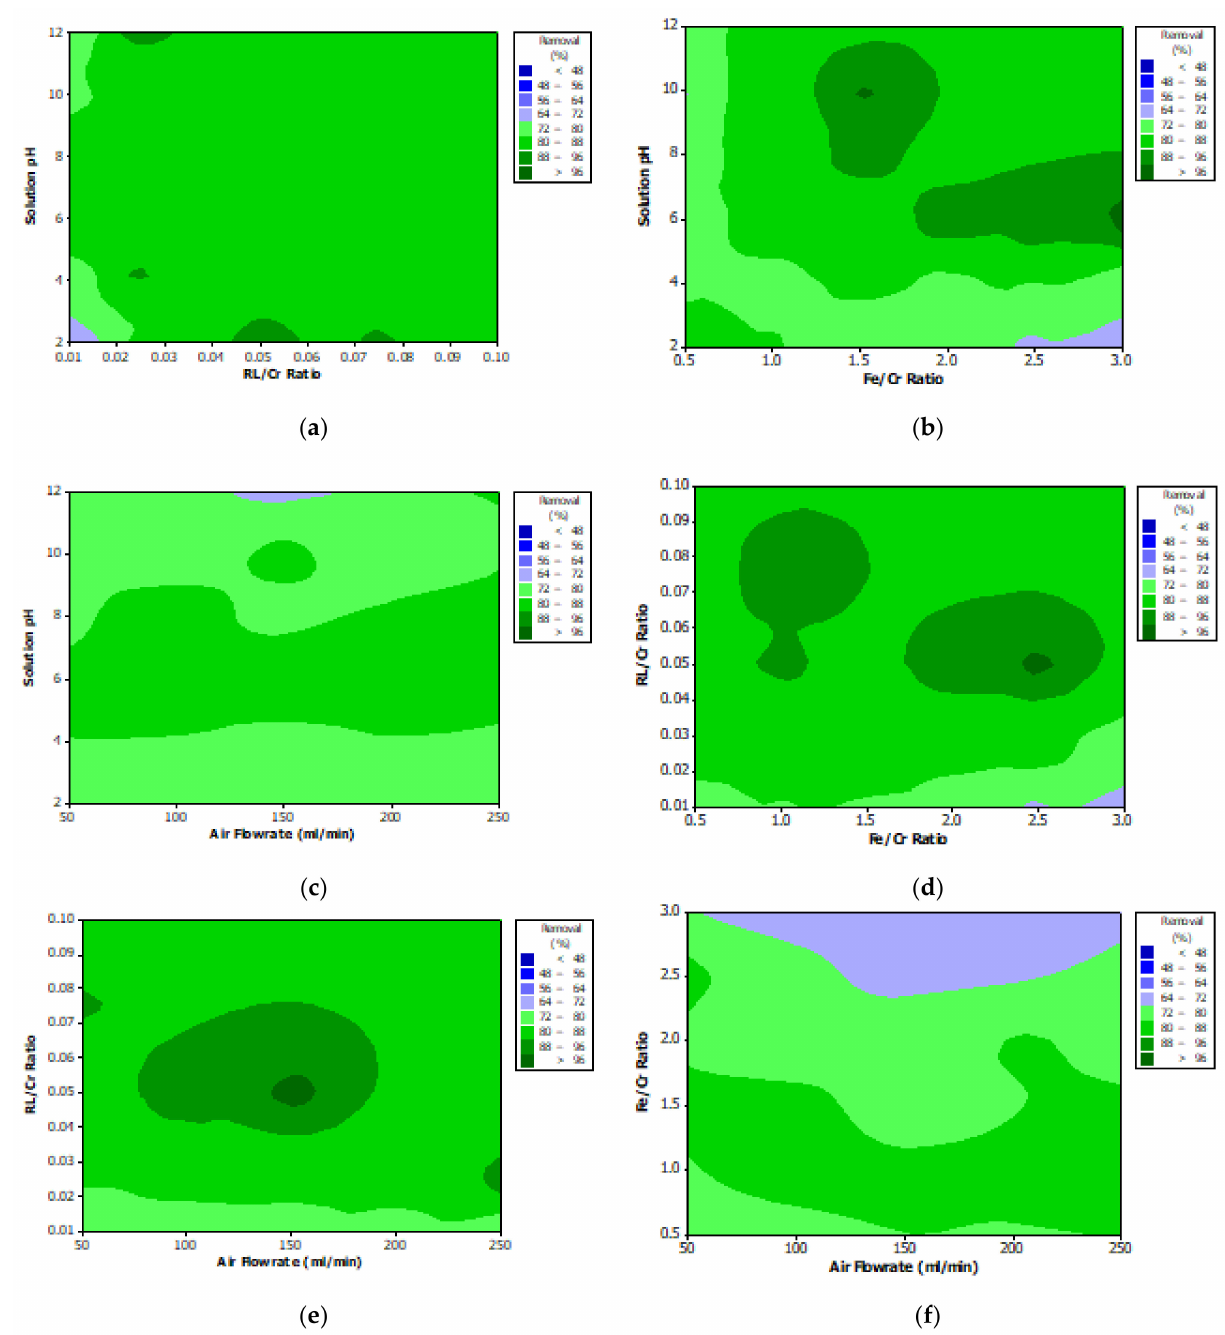
Figure 13. The interaction response plots between ( a ) pH and RL concentration, ( b ) pH and reductant concentration, ( c ) pH and air flowrate, ( d ) RL and reductant concentrations, ( e ) RL concentration and air flowrate and ( f ) reductant concentration and air